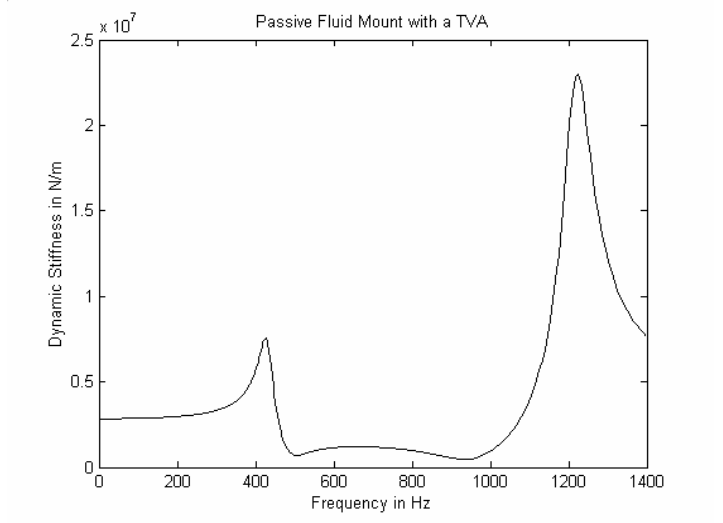
Fig. 12. Passive fluid Mount/TVA suspension system.